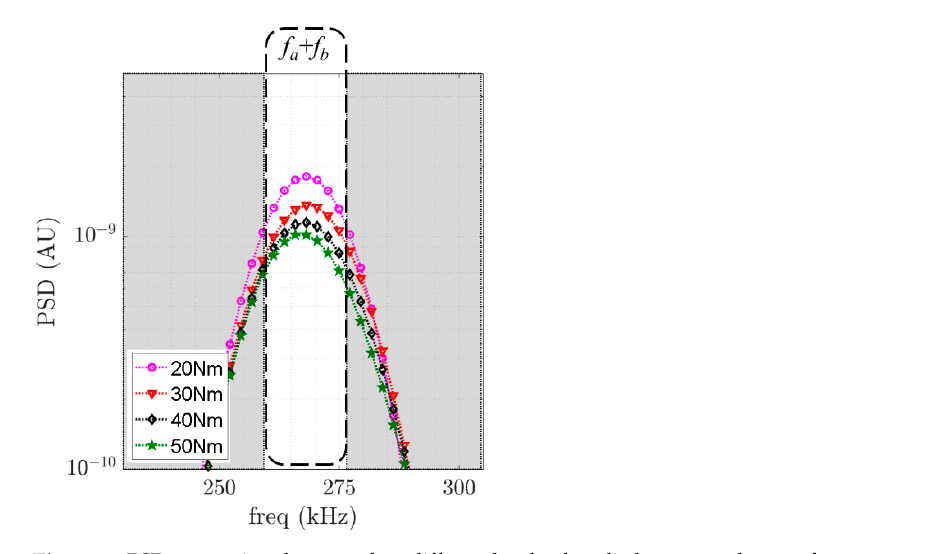
Figure 7. PSD comparison between two different applied torques.